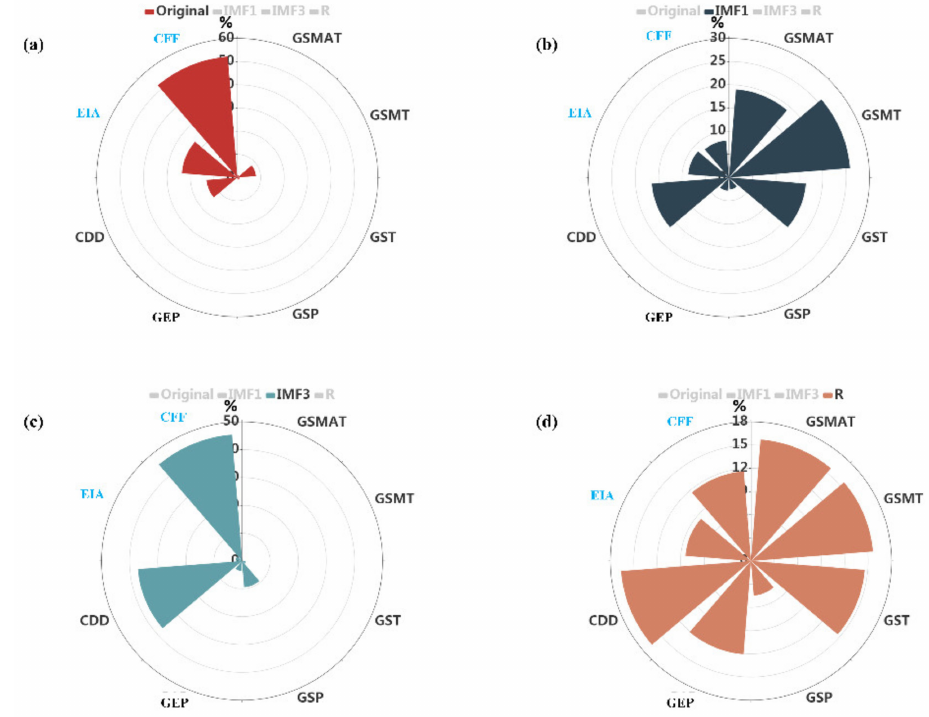
Figure 6. The sensitivity analysis of maize yield (original ( a ), IMF1 ( b ), IMF3 ( c ), and R ( d )) to climate change and human activities at different timescales based on the DVVD method.